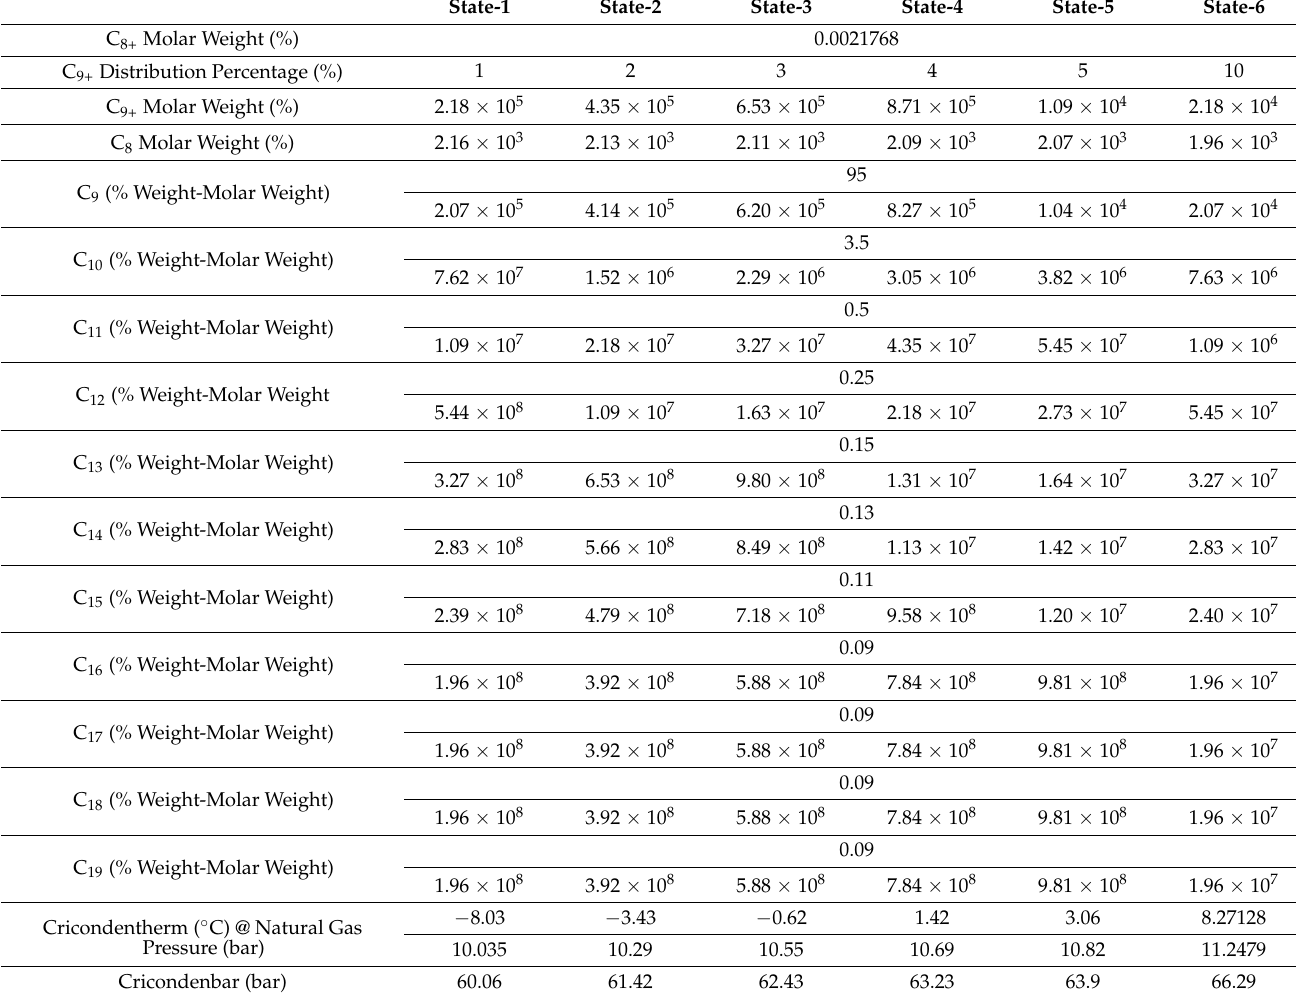
Table A2. C 9 –C 19 data analysis of Esenyurt RM-A